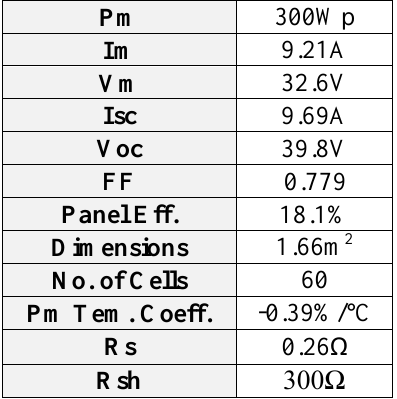
Table 3: PV panel’s parameters used in the